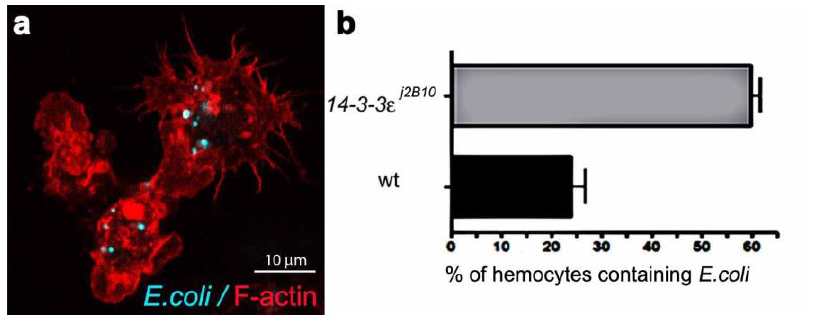
for actin-filaments, red) containing FITC-labeled E. coli (turquoise punctae). (b) Enumeration of wild-type and 14-3-3 (cid:72) protein null mutant hemocytes containing E. coli , one hour after